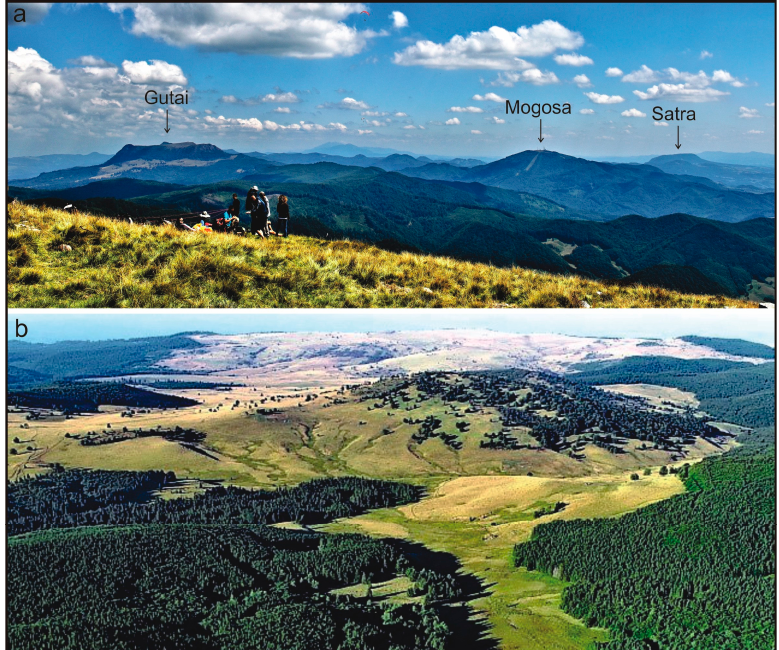
Figure 5. View toward the eastern part of the Gutâi volcanic area from the Igni ş Peak with well individualized volcanic structures of large-sized Gutâi extrusive dome, Mogo ş a composite volcano, and Ş atra dome ( a ). The northern zone of the Gutâi Mountains with typical landforms on the extended lava plateaus ( b ) (Photos credit: Péter Lengyel).